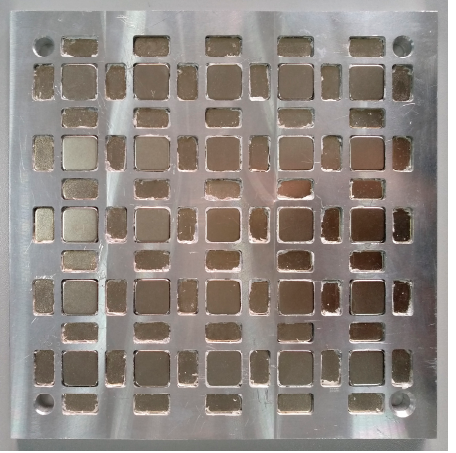
Figure 7. The magnet array built according to the optimized parameters. Table 4. Parameters of the proposed magnet